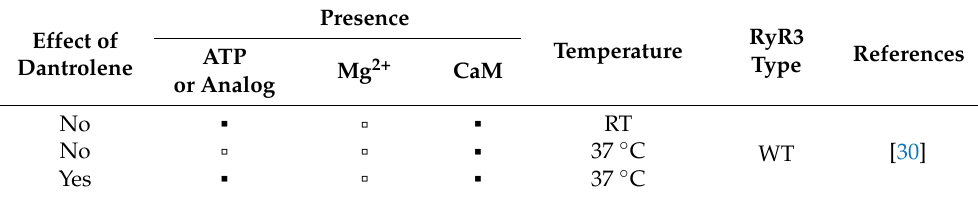
Table 1. Effect of dantrolene on the RyR1 channel in cell-free experiments. ATP, Mg 2+ , CaM, and dantrolene were added to the RyR1 cytosolic face.